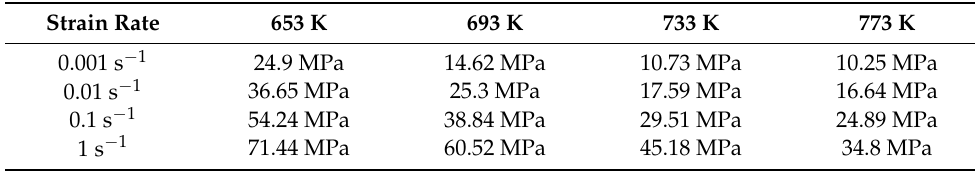
Figure 1. True stress – strain curves of the alloy during hot compression. ( a ) 653 K; ( b ) 693 K; ( c ) 733 K; ( d ) 773 K. Table 1. Peak stress of the Mg – 8 wt.% Sn – 1.5 wt.% Al alloy.